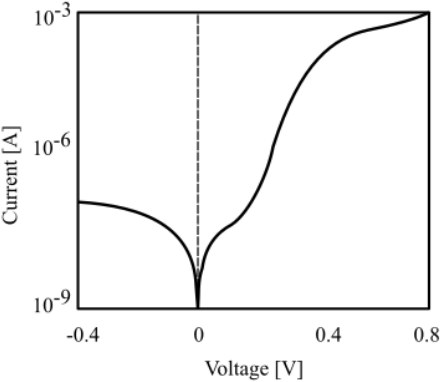
( b ) Figure 14. Four Quadrant Power Supply tracer. Source [16] , own elaboration. Investigation of the operation of four quadrants on a solar module allows the diag- nosis of mismatches in partially shaded cells connected in series and is used for the gen- eration of dark curves (dark I–V curve). The dark I–V curve is the curve of the module